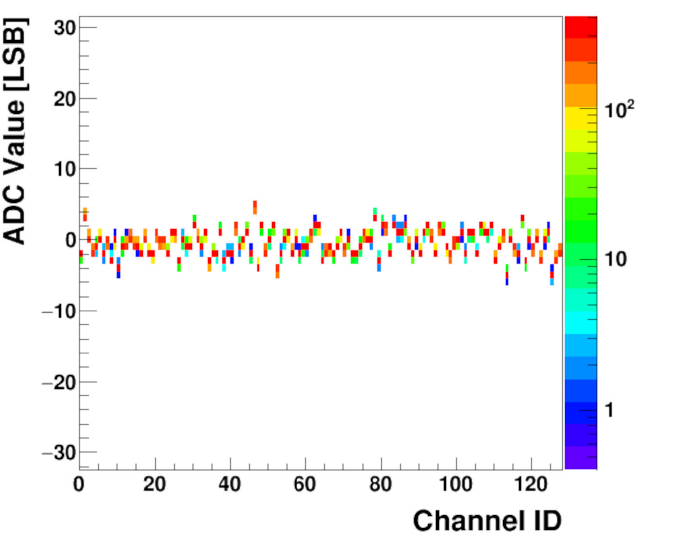
Figure 12. Baseline noise histogram for all trim DACs set to the default value 128; colour indicates bin height; sensor not